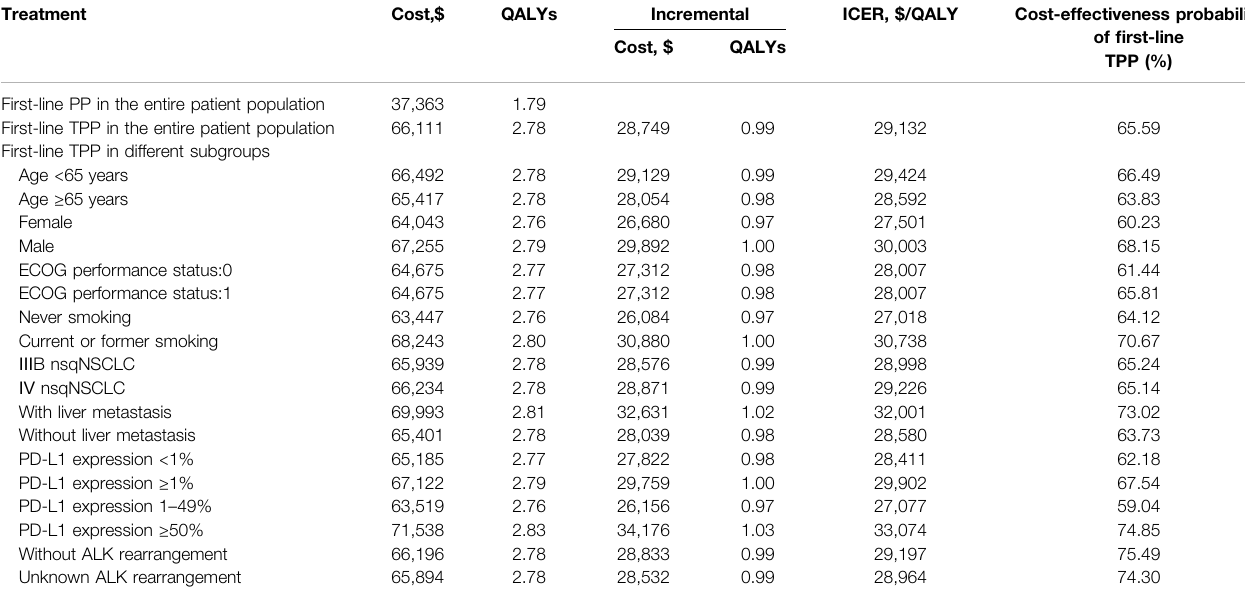
TABLE 1 | Cost-effectiveness analysis summary.